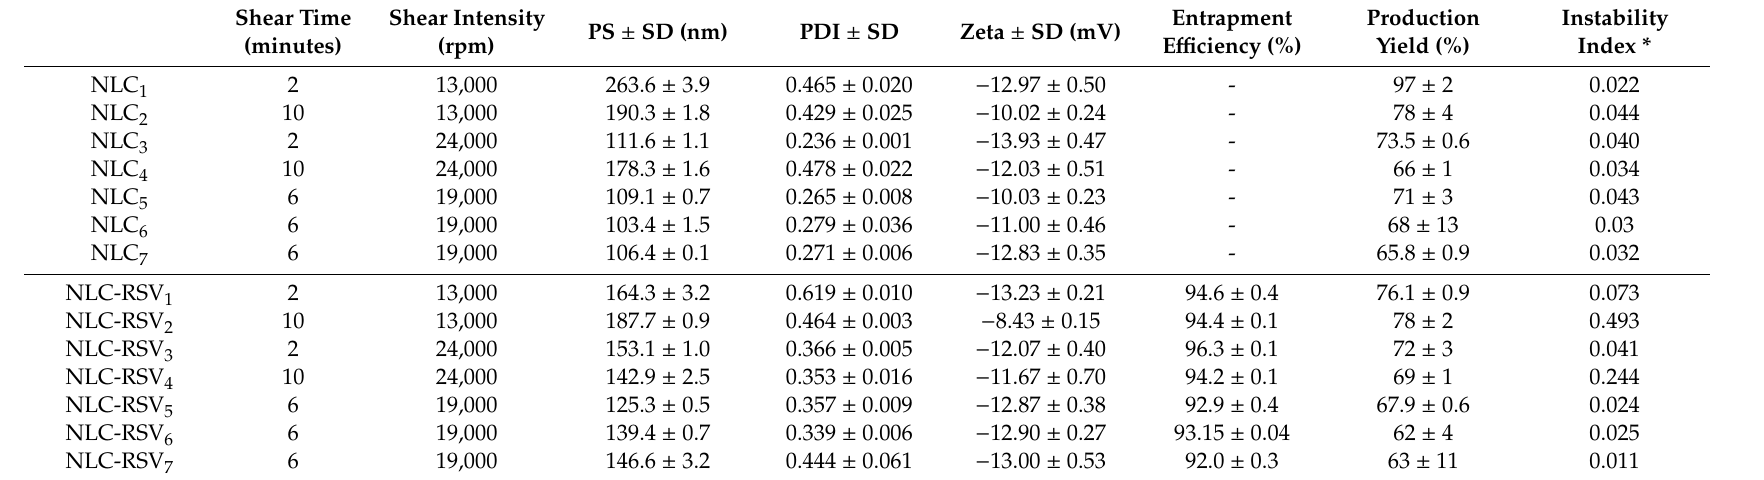
Table 3. Influence of shear intensity and homogenization time on the production of